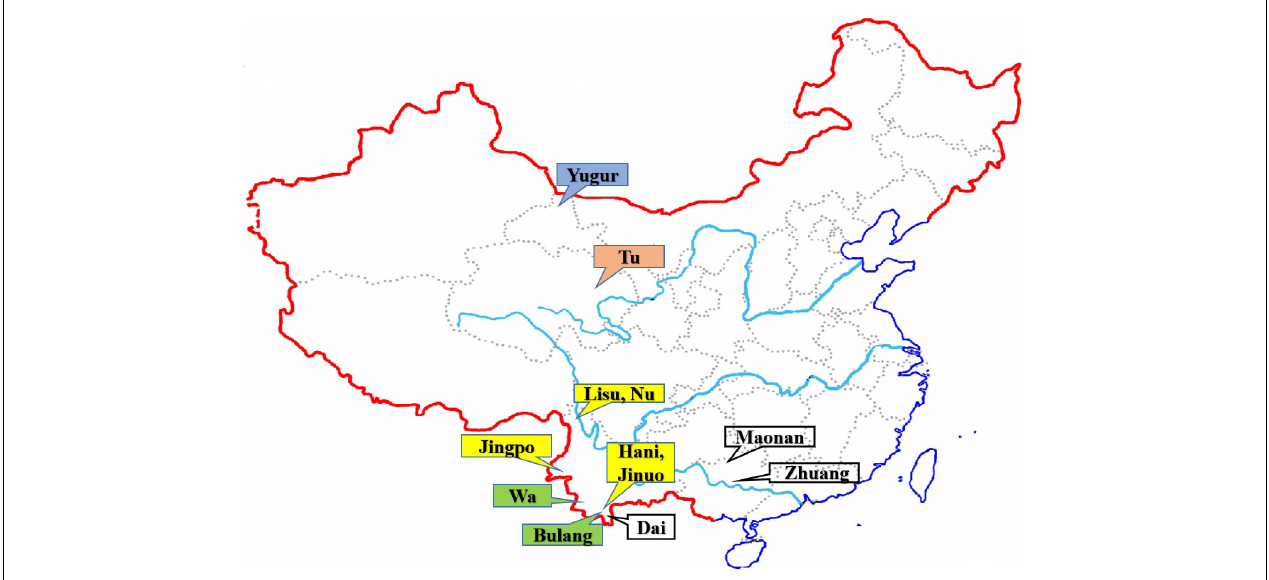
FIGURE 1 | The geographic locations of the 12 Chinese ethnic populations in China. The colored labeled boxes represent the ancient tribe, language family and subfamily for each population listed in Table 1 . Yellow represent Di-Qiang, Sino-Tibetan, Tibeto-Burman. Green represent Baipu, Austo-Asiatic, Mon-Khmer. White represent Baiyue, Sino-Tibetan, Daic. Orange represent Mongolian, Altaic, Mongolian. Blue represent Mongolian, Altaic,